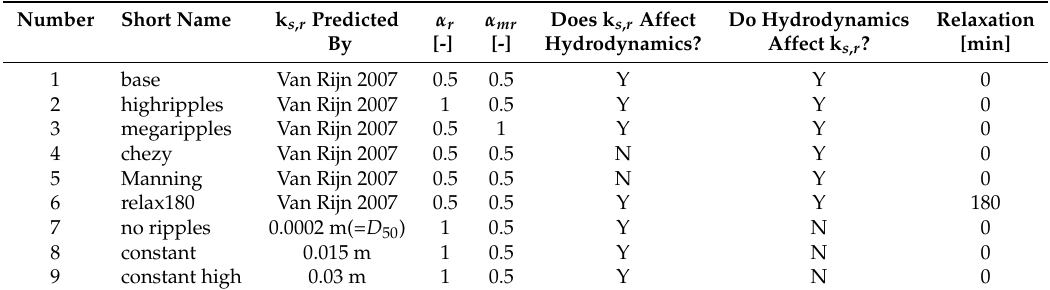
Table 2. Overview of model